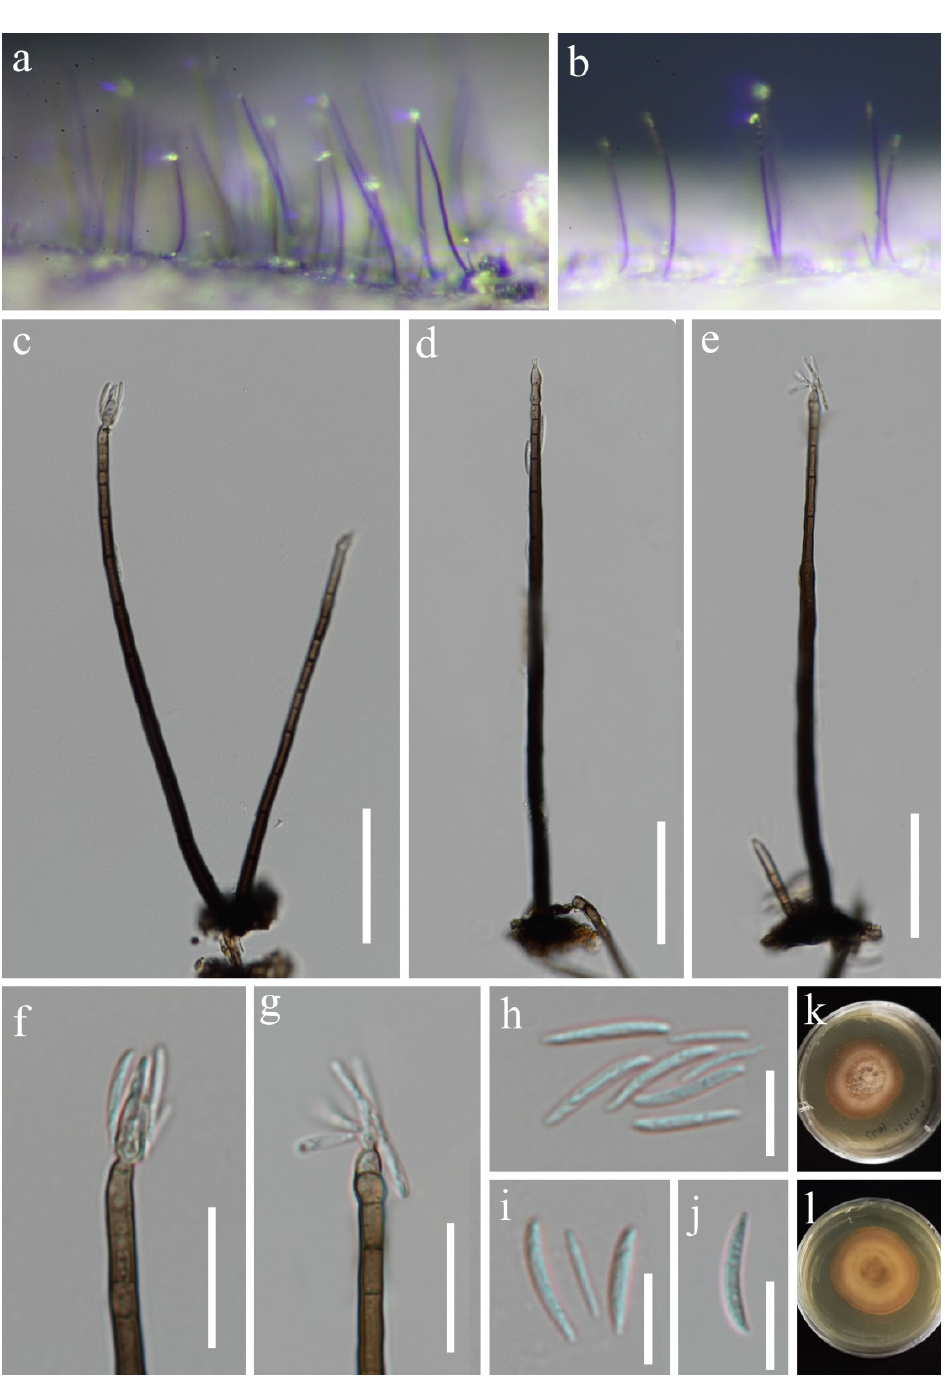
Figure 7. Dictyochaeta guizhouensis (HKAS 123753, holotype). ( a , b ) Colonies on dead wood; ( c – e ) conidiophores; ( f , g ) conidiogenous cells; ( h – j ) conidia; ( k,l ) culture on PDA from above and below. Scale bars: ( c – e ) 50 μ m; ( f , g ) 20 μ m; ( h – j ) 10 μ m.